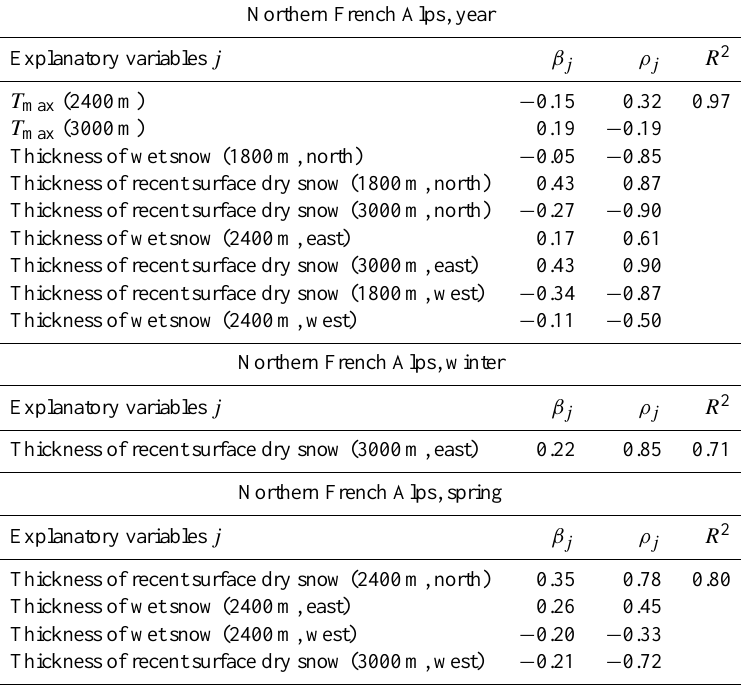
Table 2. Regression model characteristics for the northern French Alps (all year, winter and spring periods). For each retained explanatory variable X norm , β j is the corresponding weighting coefficient in the model; ρ j is the correlation coefficient between X norm jt composite index; and R 2 is the determination coefficient of the